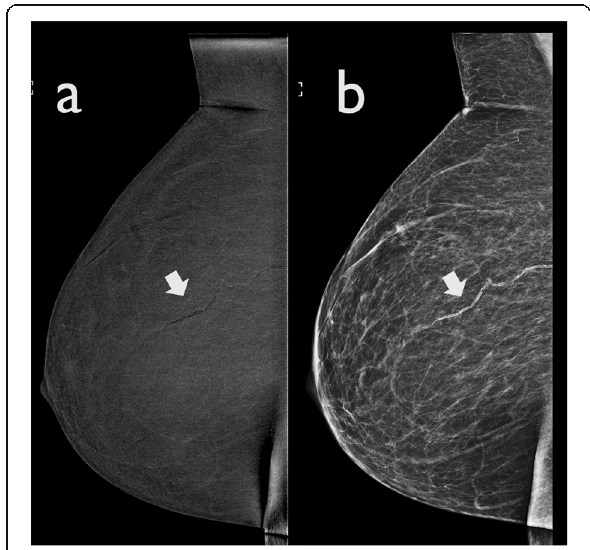
Fig. 9 Negative contrast enhancement. a CEDM recombined image presents an irregular, tubular structure (arrow), which is black in relation to the surrounding background. b In LE CEDM image, this wavy band corresponds to a calcified blood vessel (arrow)